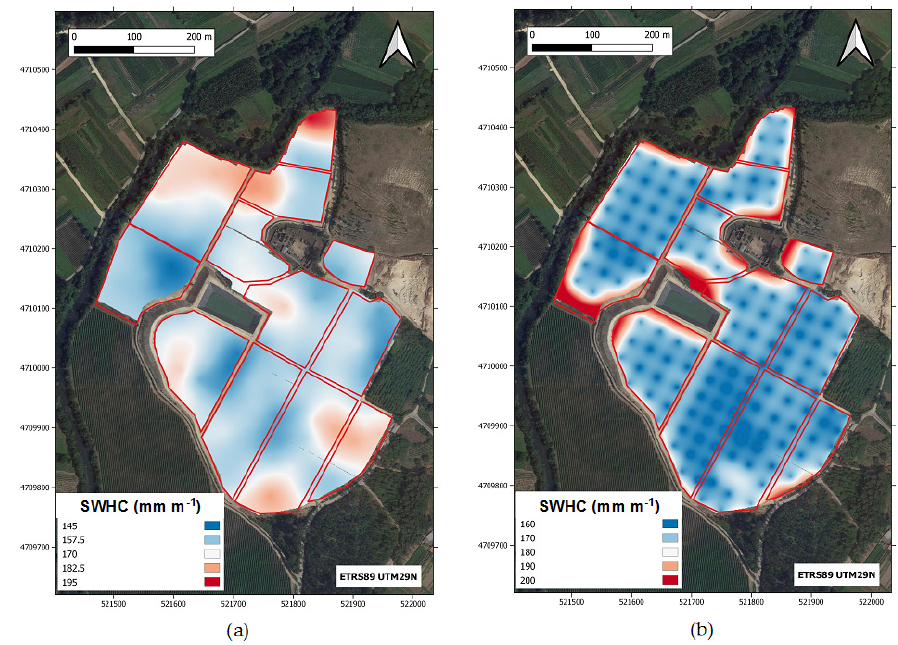
Figure 11. Estimation ( a ) and error ( b ) maps of soil water holding capacity over the experimental vineyard generated by ordinary kriging. The light blue dots represent the sampling points.